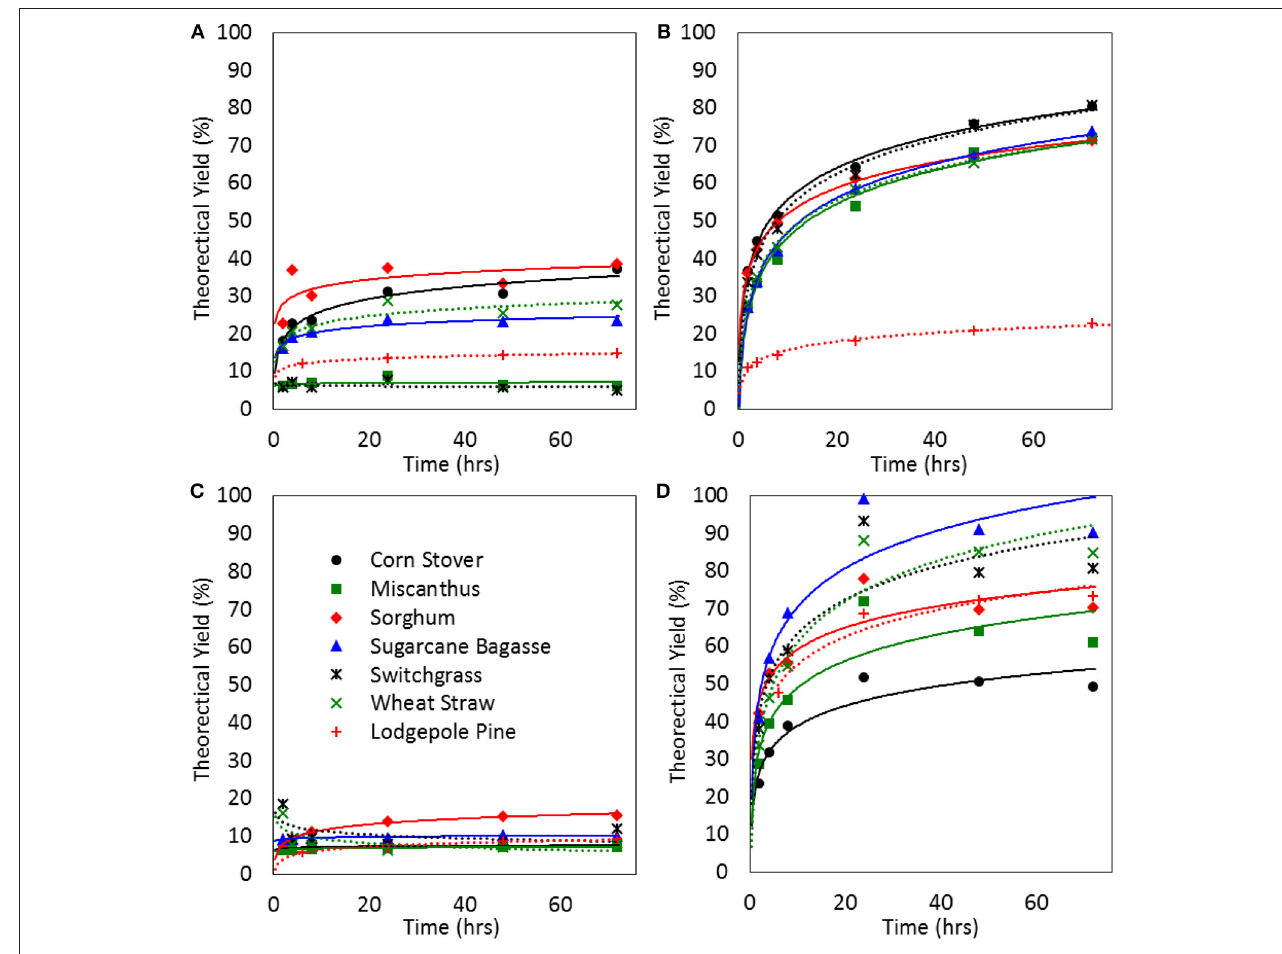
FIGURE 6 | Enzymatic hydrolysis data points (markers) and trends (lines) for raw biomass (A) , dilute acid pretreated biomass (B) , Bmin PF 6 pretreated biomass (C) , and Emin Ac pretreated biomass (D) . The legend visible in (C) applies to all of the panels in the figure. Theoretical sugar yield is the sum of glucan, xylan, galactose, arabinose, mannose, and cellobiose released divided by the sugars in the pretreated